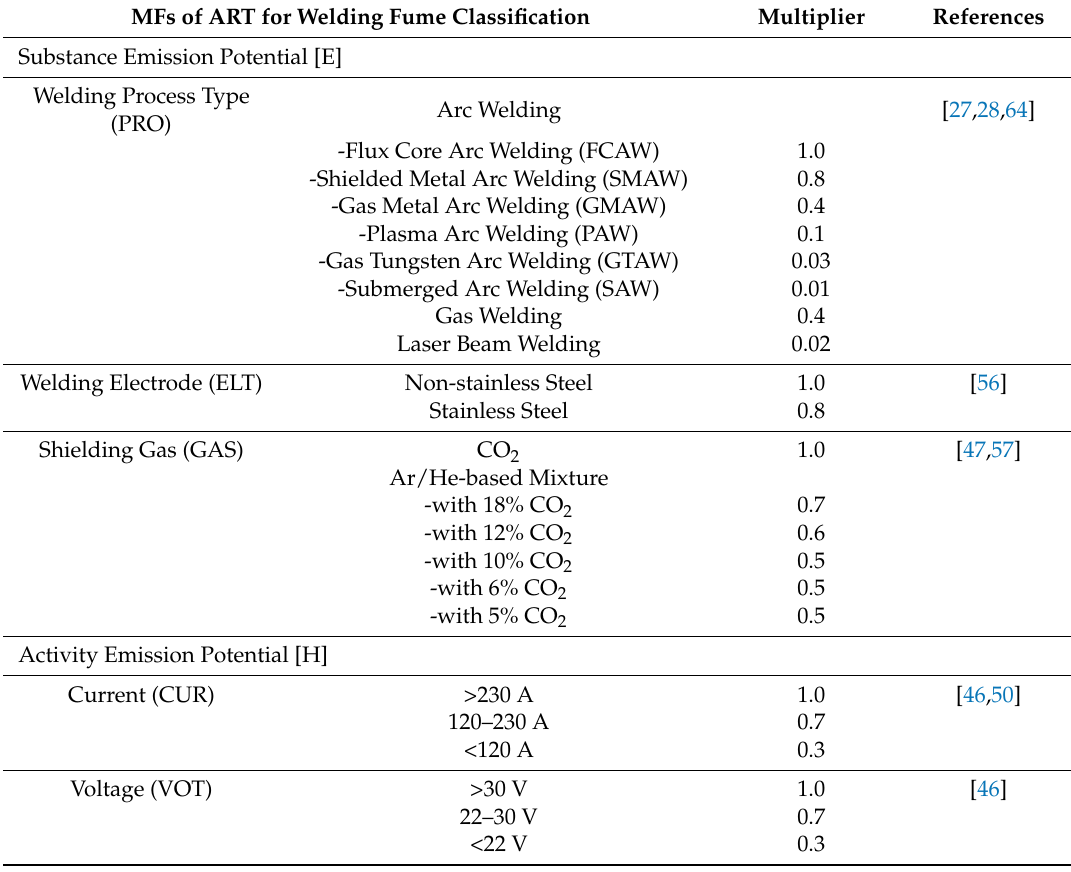
Table 1. Modifying factor scoring for ART welding fume exposure